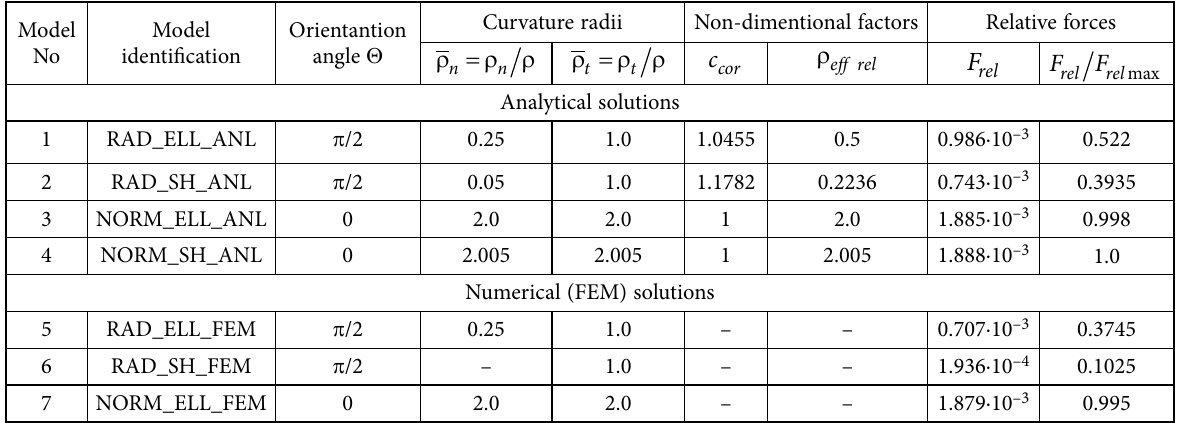
Table 2. Summary of contact analysis